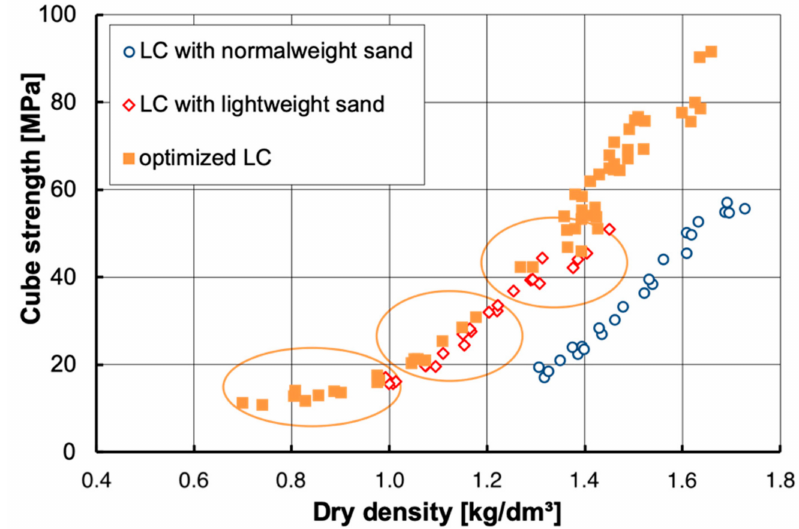
Figure 8. Correlation between 28-day cube strength and dry density for lightweight concretes with di ff erent compositions